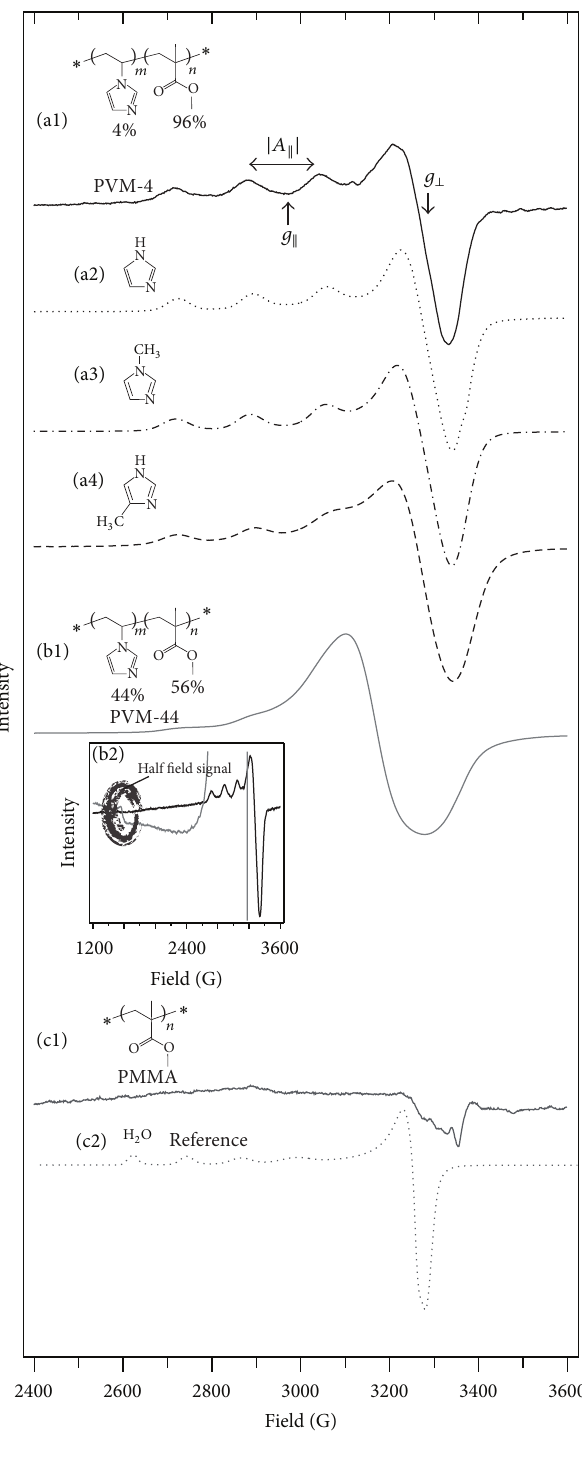
Figure 2: Cu 2+ EPR spectra in MeCN of (a1) PVM-4, (a2) Im, (a3) Me(1)-Im, (a4) Me(4)-Im, (b1) PVM-44, (b2) PVM-44 half field sig- nal, (c1) PMMA, and (c2) H 2 O [38, 47]. The paramagnetic centers, that is, the Cu(II) ions, of PVM-44 are closer together compared to PVM-4 which is reasonable due to the larger fraction of imidazole ligands per polymer chain. To be more precise, the coordination complexes are separated by less than 20 ˚A (see Figure 2(b2)) which is indicated by the EPR half field signal (see Figure